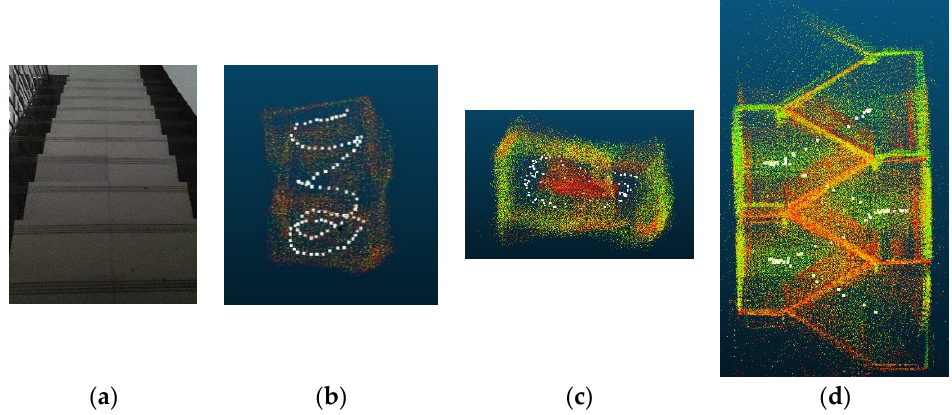
Figure 11. ( a ) Stairs scene for experiment 2. ( b ) Mapping results of LeGO-LOAM in the stairs scene, with LeGO-LOAM’s mapping result having failed. ( c ) Mapping results of LIO-SAM in the stairs scene, with LIO-SAM’s mapping results lacking height information. ( d ) Mapping results of HSDLIO in the stairs scene, with the mapping of HSDLIO the most complete and accurate.